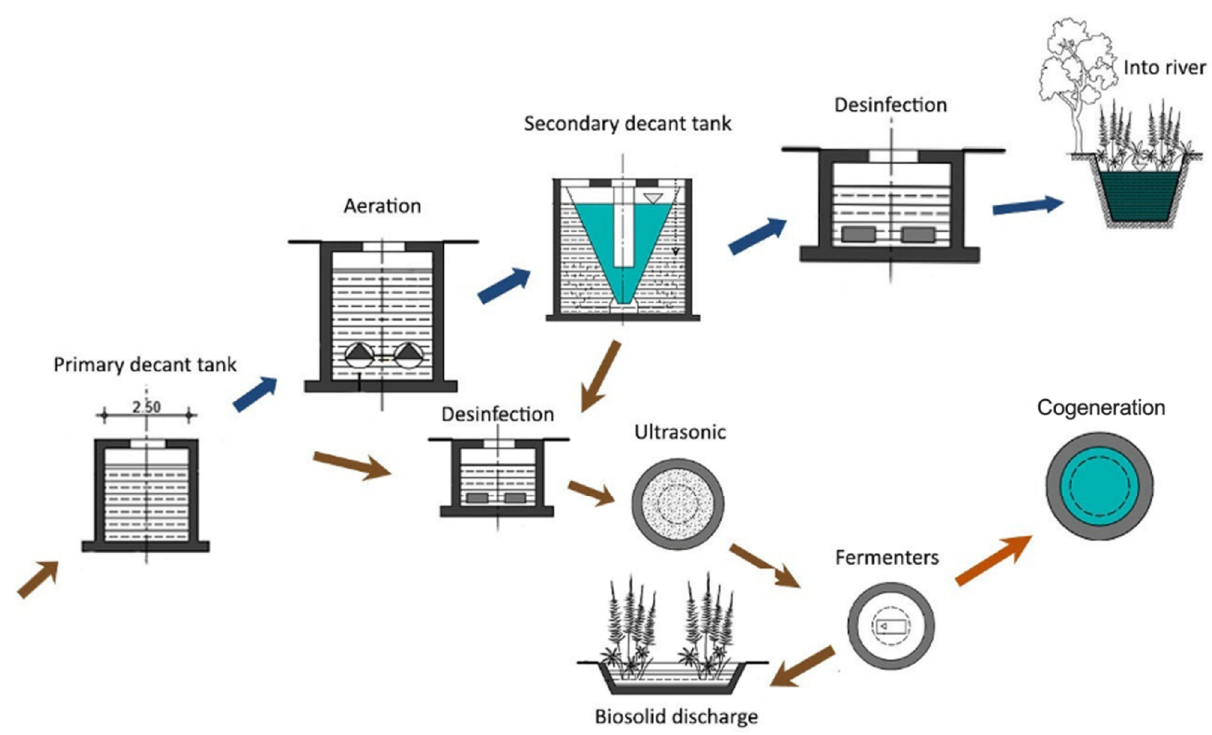
Figure 3. The improvement for the use of an optimal quality of sludge in agriculture in order to obtain biosolids.